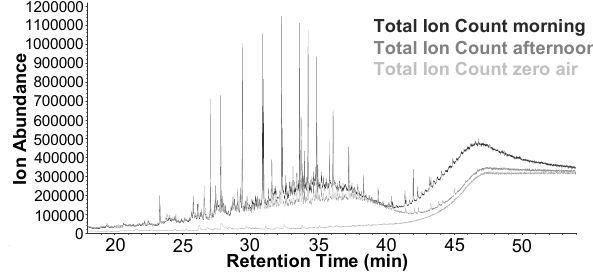
Fig. 3. Comparison of typical TAG chromatograms during SOAR. GC compound retention time (in minutes) is displayed on the x- axis, with total ion abundance on the y-axis. The dark-shaded grey chromatogram (highest abundance) is representative of a typical morning sample (with lots of nonvolatile organic material appear- ing > 40min). The medium-shaded grey chromatogram is repre- sentative of a typical afternoon sample (with additional oxygenated compounds appearing < 30min). The light-shaded chromatogram is representative of a typical zero air